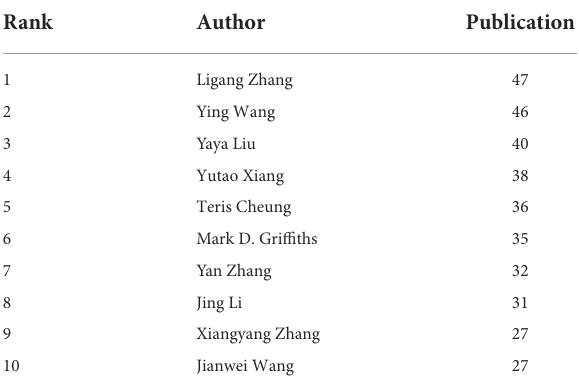
TABLE 6 Top 10 most productive authors ranked by number of